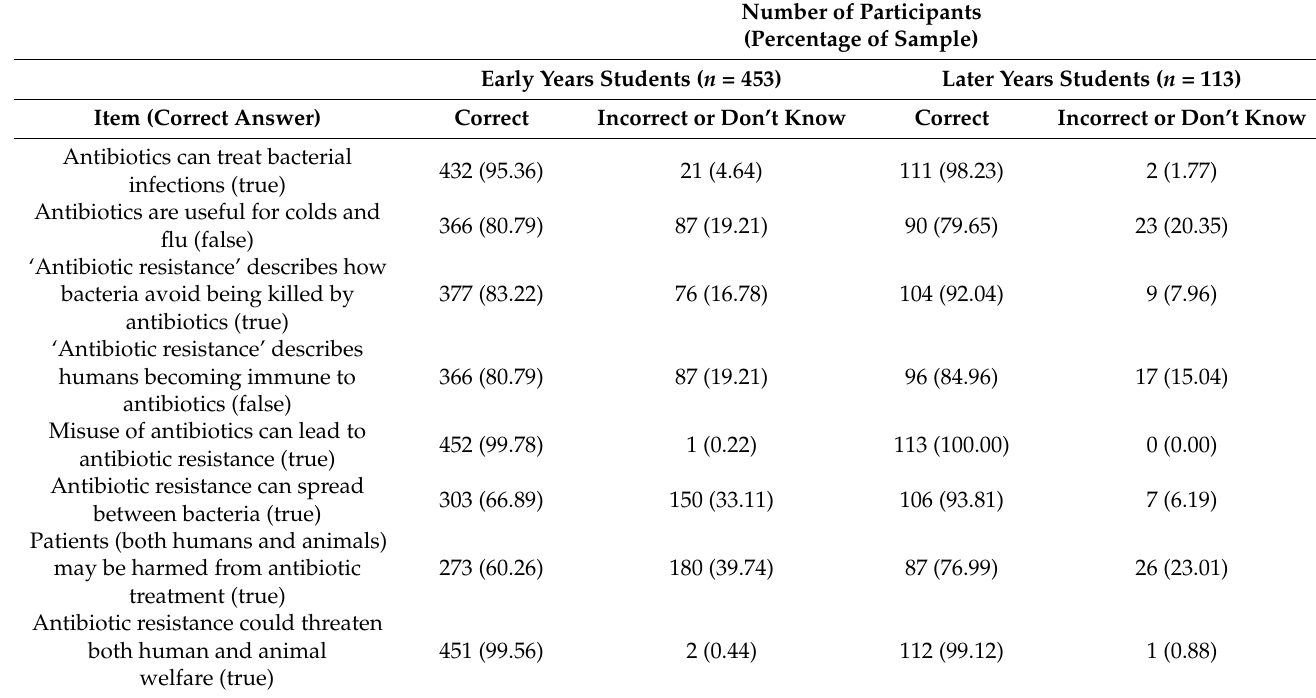
Table 5. Rates of correct knowledge per